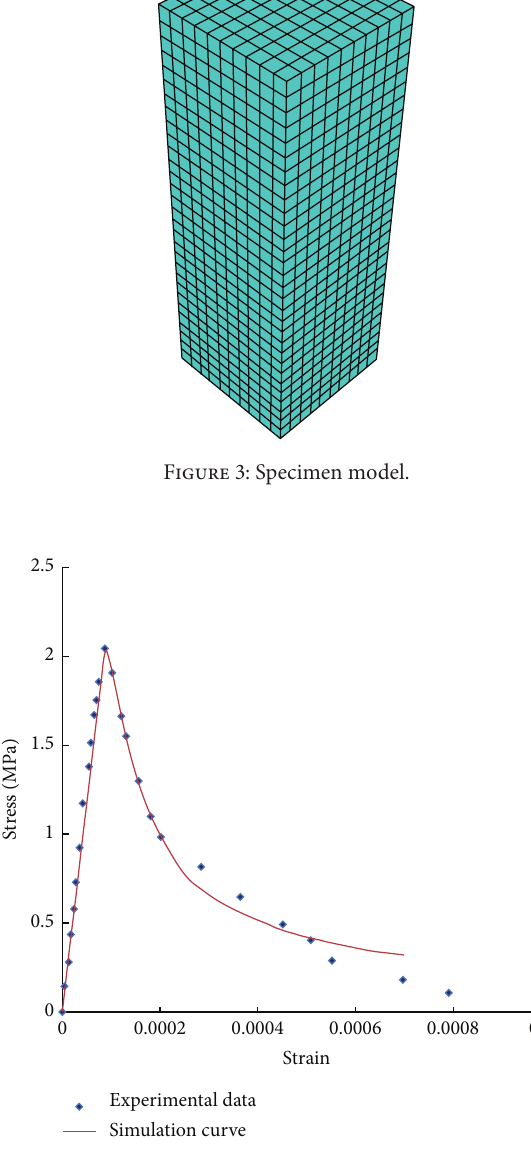
Figure 4: Comparison of stress-strain relationship between numer- ical simulation and experimental tests for specimen